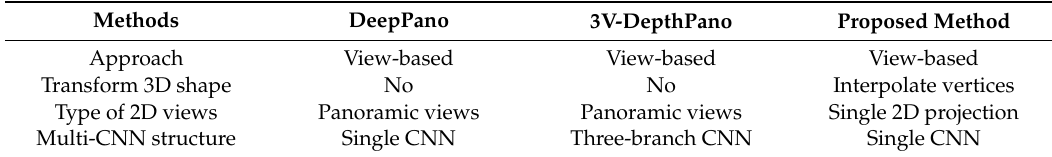
Table 1. A comparative overview among